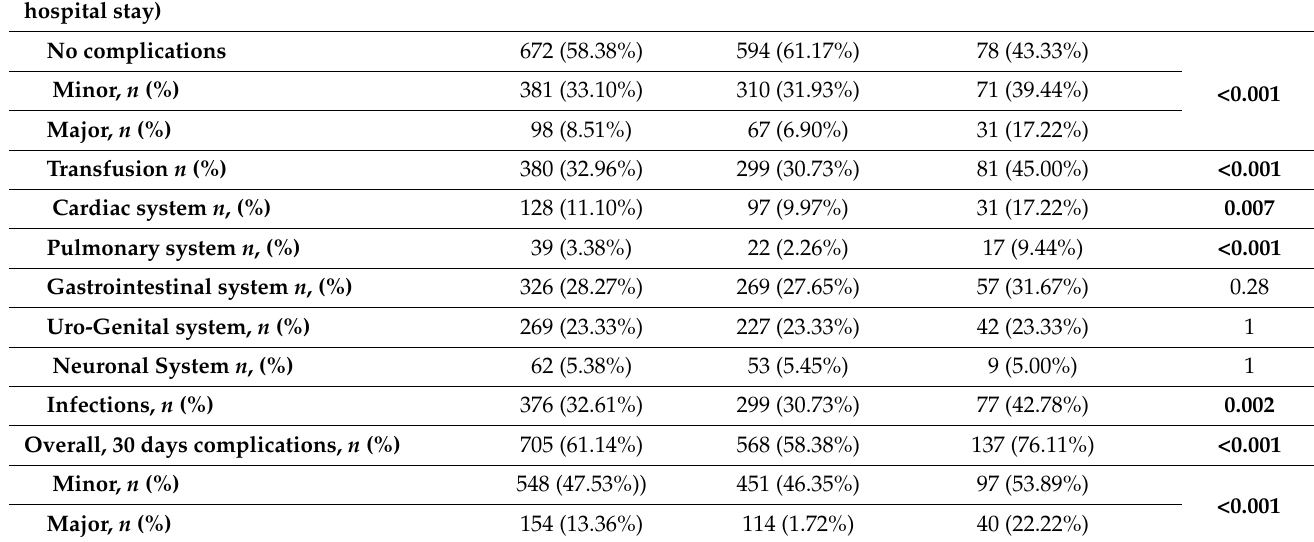
Home (with Continued Facility-Based Total Home Care) Rehabilitation Centers